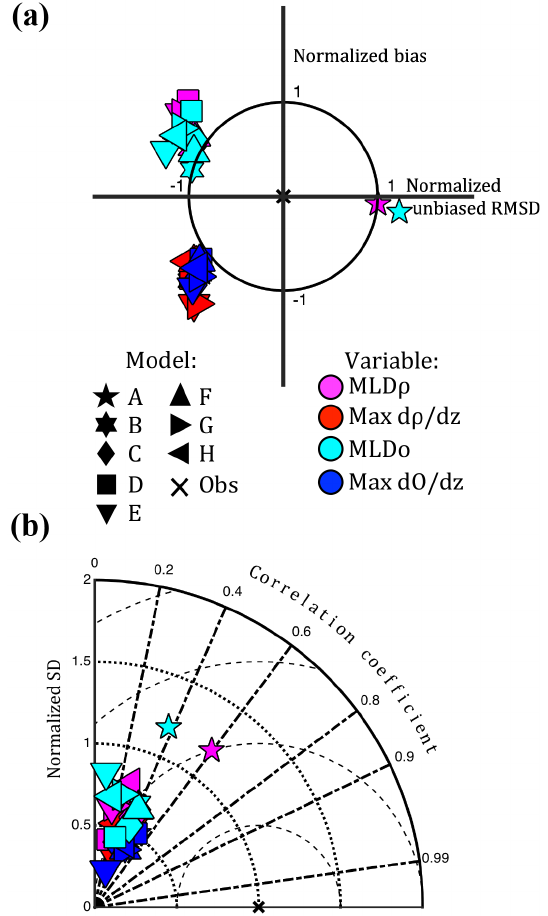
Figure 6. Normalized summary (a) target and (b) Taylor diagram illustrating model skill of MLD ρ and MLD O , max d ρ/ d z , and max dO / d z at 13 Chesapeake Bay stations for 2004–2005. The “x” rep- resents the skill of a model that perfectly reproduces the observa- tions. Since RMSD of stratification is only computed at stations where both the observations and model exhibit stratification, the Model Mean is not calculable for these